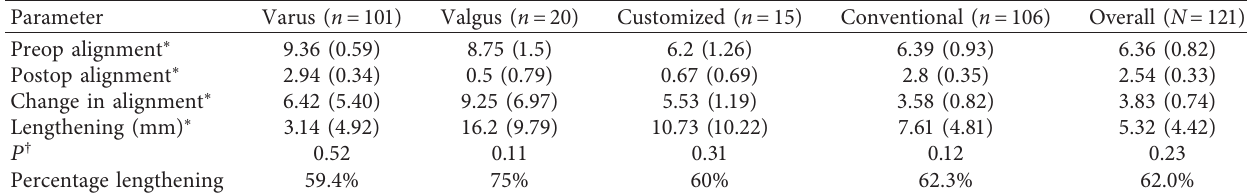
Table 2: Measurement results.